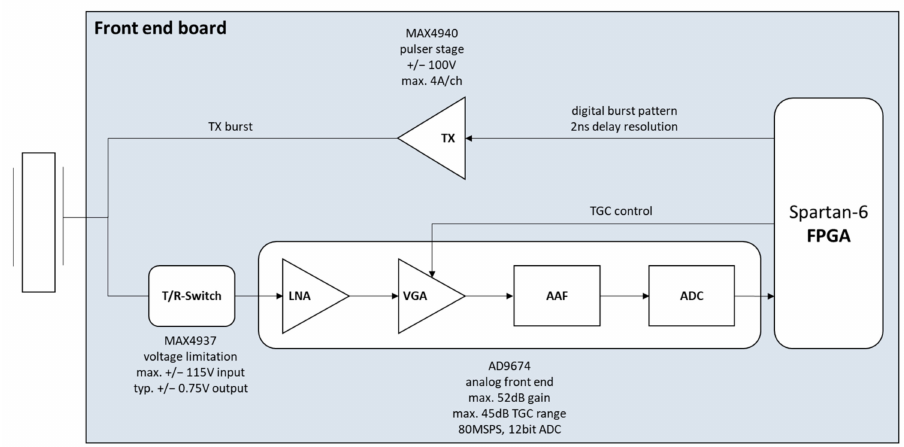
Figure 5. Simplified TX/RX channel on the front-end